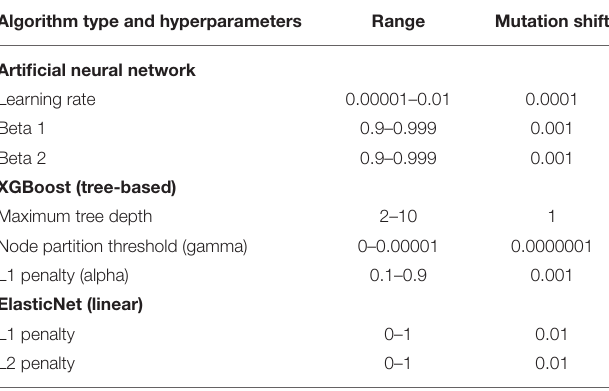
TABLE 2 | Hyperparameters tuned via integrated evolutionary learning. Algorithm type and